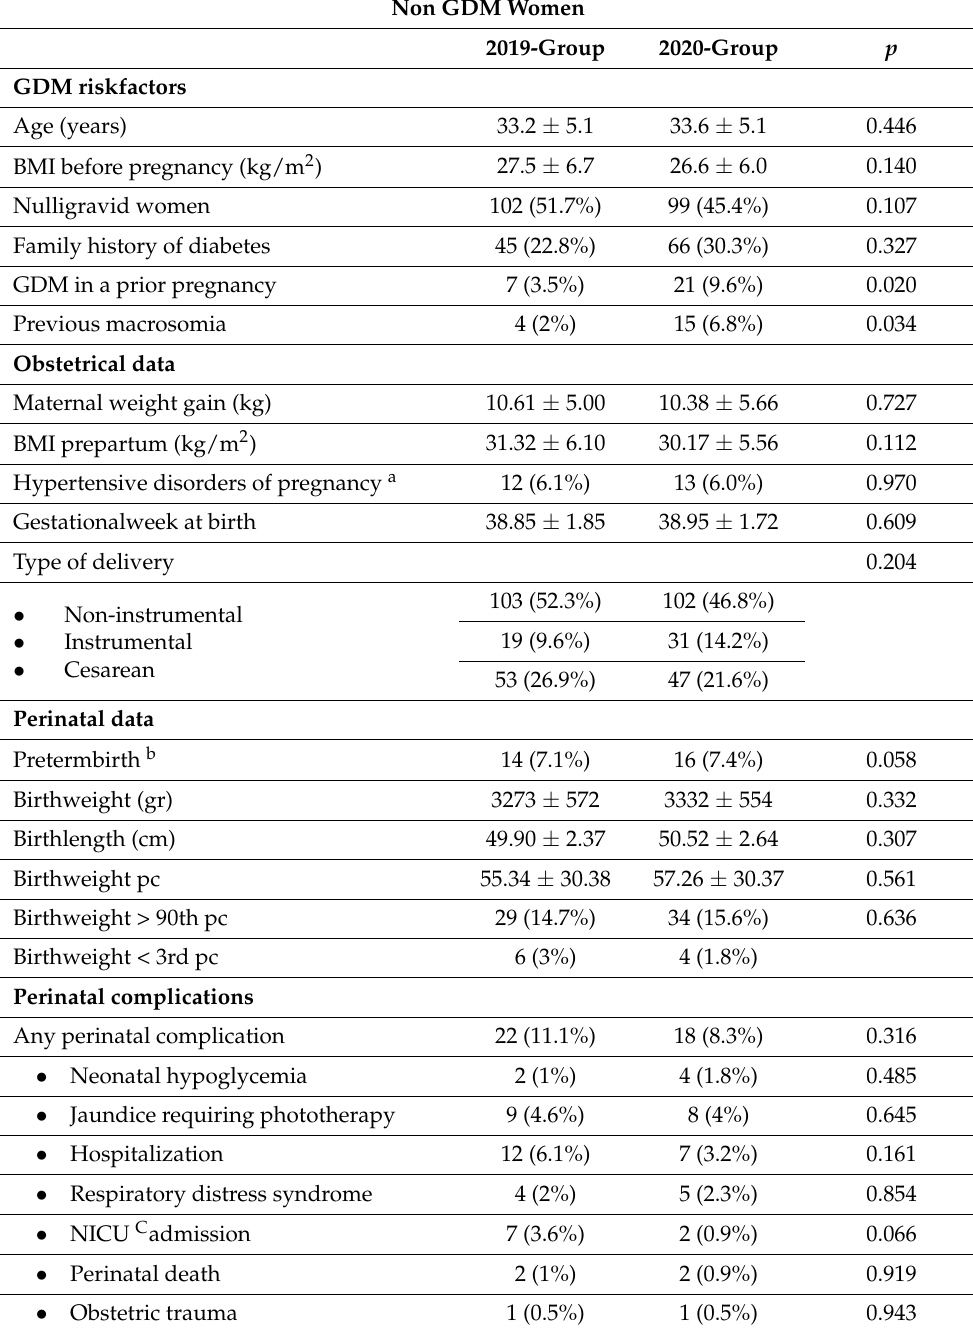
Table 3. Comparison between non-GDM women in 2019-group vs. 2020-group: GDM risk factors, obstetrical and perinatal